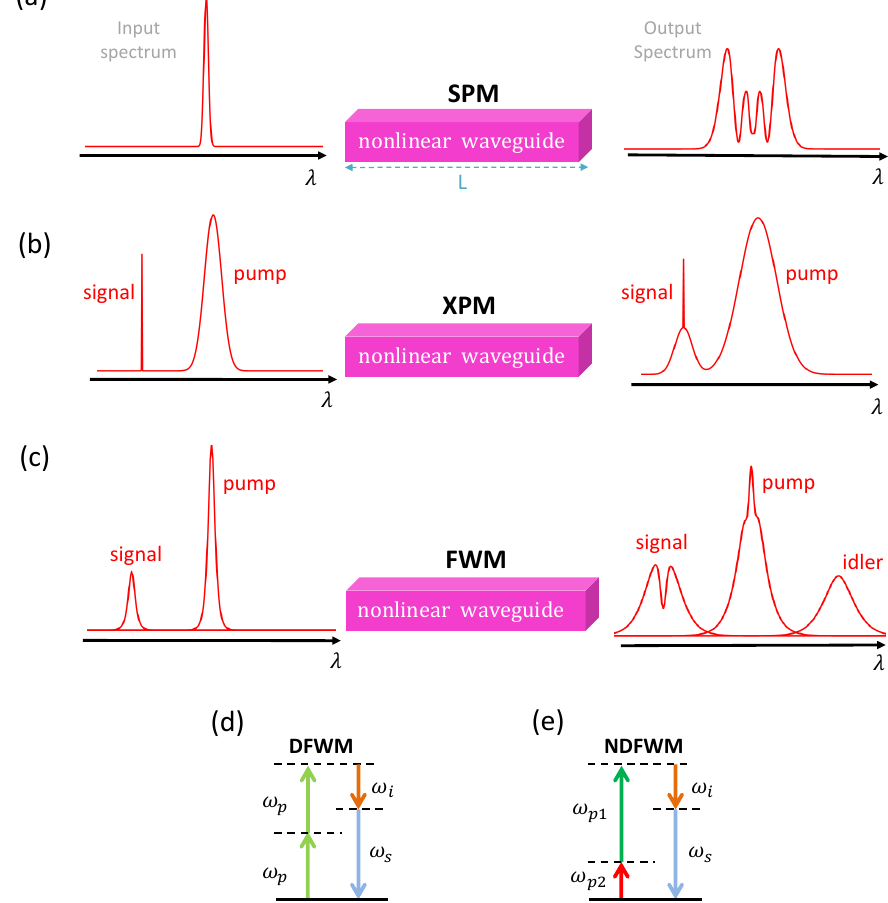
Figure 11. Spectral representations of some n 2 -related nonlinear optical phenomena: ( a ) SPM, ( b ) XPM, and ( c ) FWM. The signal spectrum may appear broadened due to the SPM and XPM effects. The energy diagrams represent ( d ) degenerate FWM (DFWM) and ( e ) non-degenerate FWM